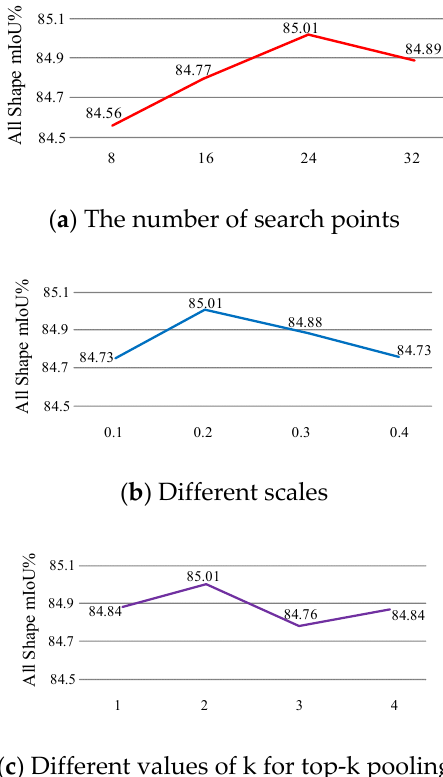
Figure 9. The comparison of key parameters in segmentation.